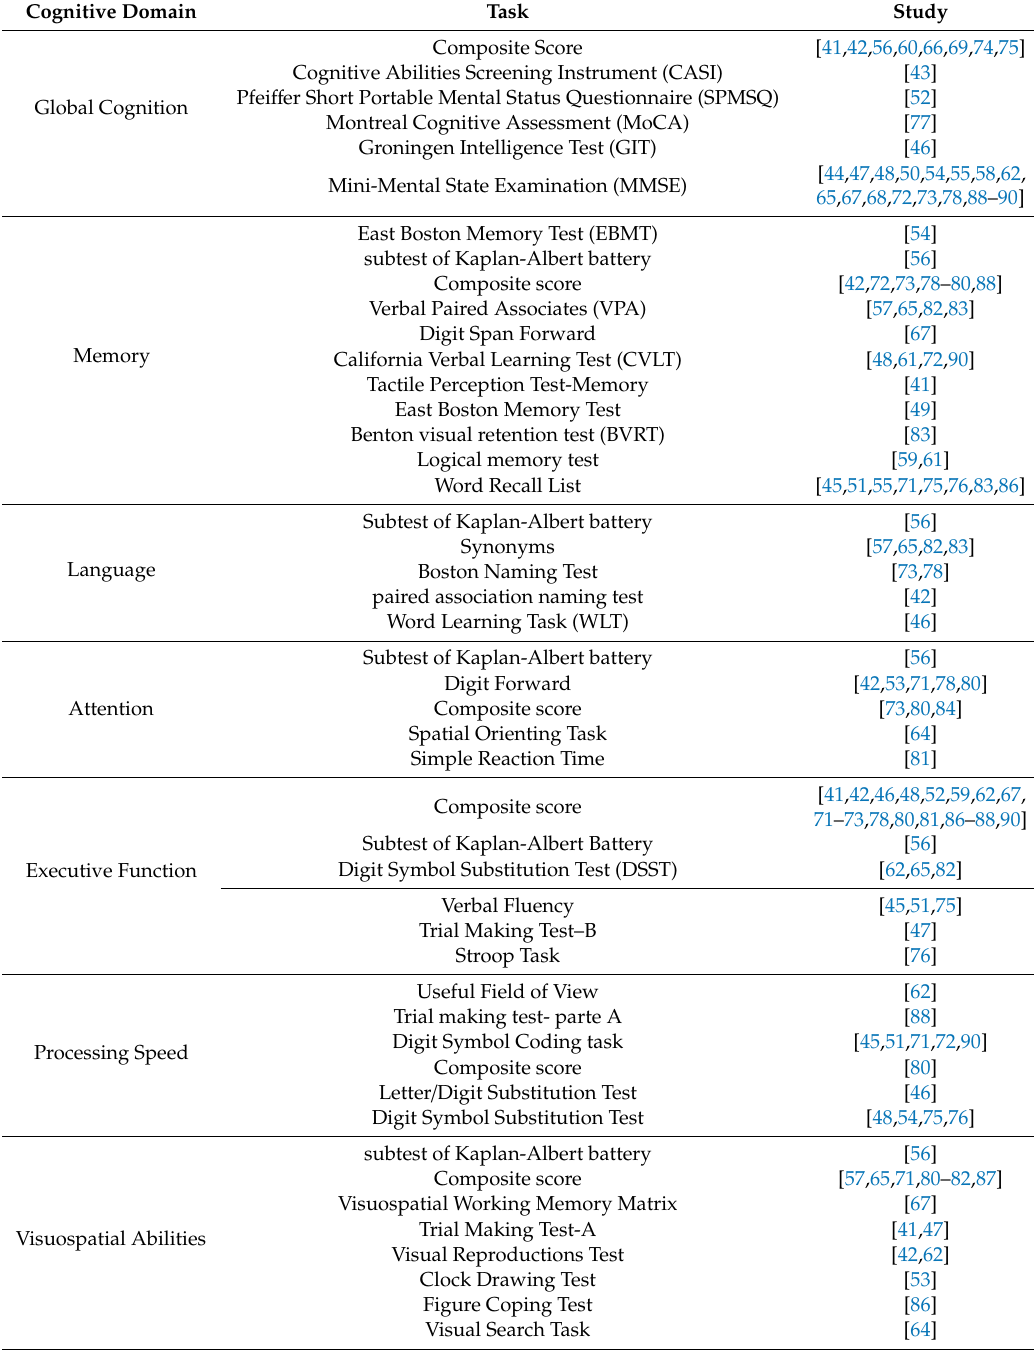
Table 3. Neuropsychological tests used for the assessment of cognitive domains in the studies on Blood